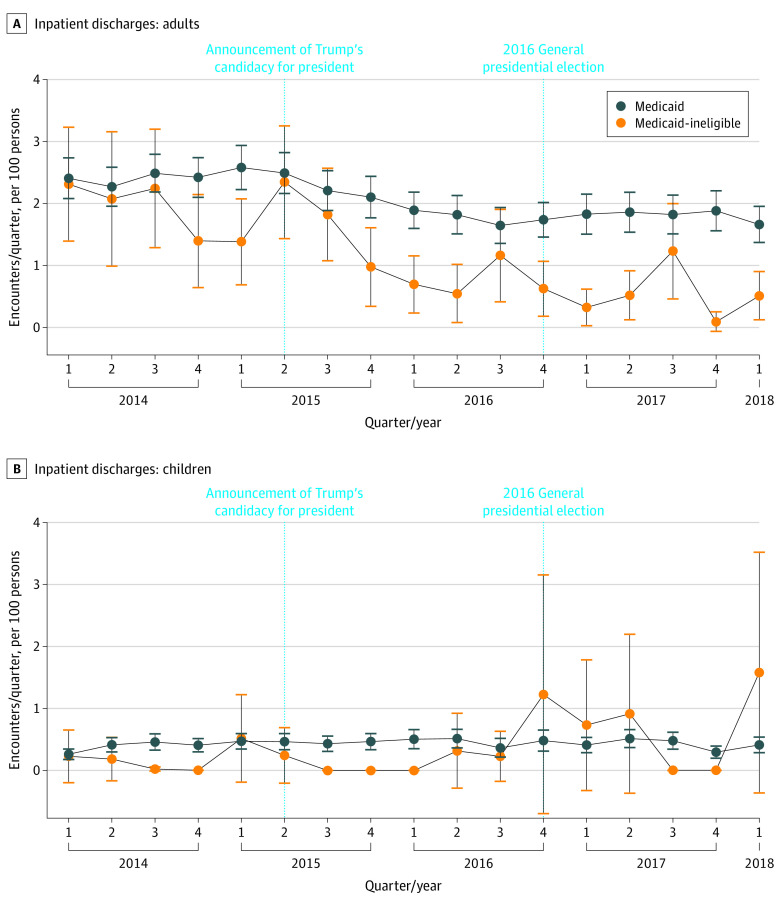
Adjusted Mean Number of Quarterly Inpatient DischargesInpatient discharges for adults (A) and children (B). Error bars show 95% CIs.